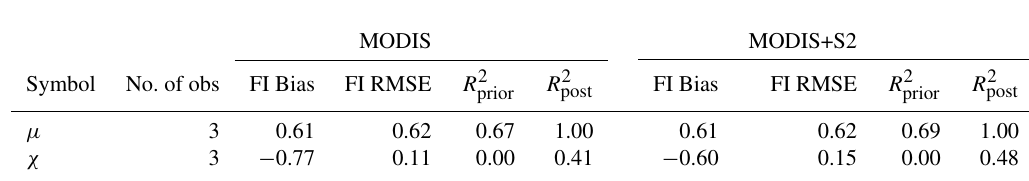
Table 6. Summary of evaluation metrics, i.e., fractional improvement in bias and RMSE, as well as prior and posterior square correlation coefficient ( R 2 ), using the ES-MDA ( N e = 10 2 , N a = 4) for peak mean SWE ( µ ) and coefficient of variation ( χ ) when assimilating only MODIS as well as assimilating both MODIS and Sentinel-2 observations. These metrics are based on a comparison to all the snow surveys conducted in 2016 (see Table 1) and are averaged over 10 2 independent runs, each with 100 ensemble